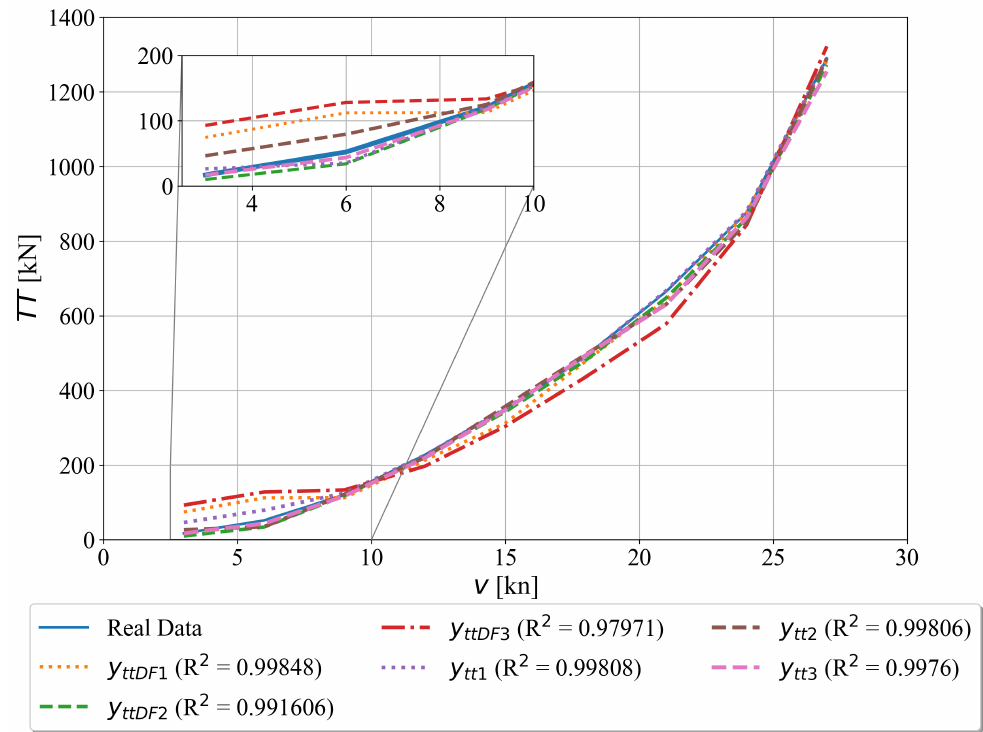
Figure 11. The variation of real and estimated total torque versus ship